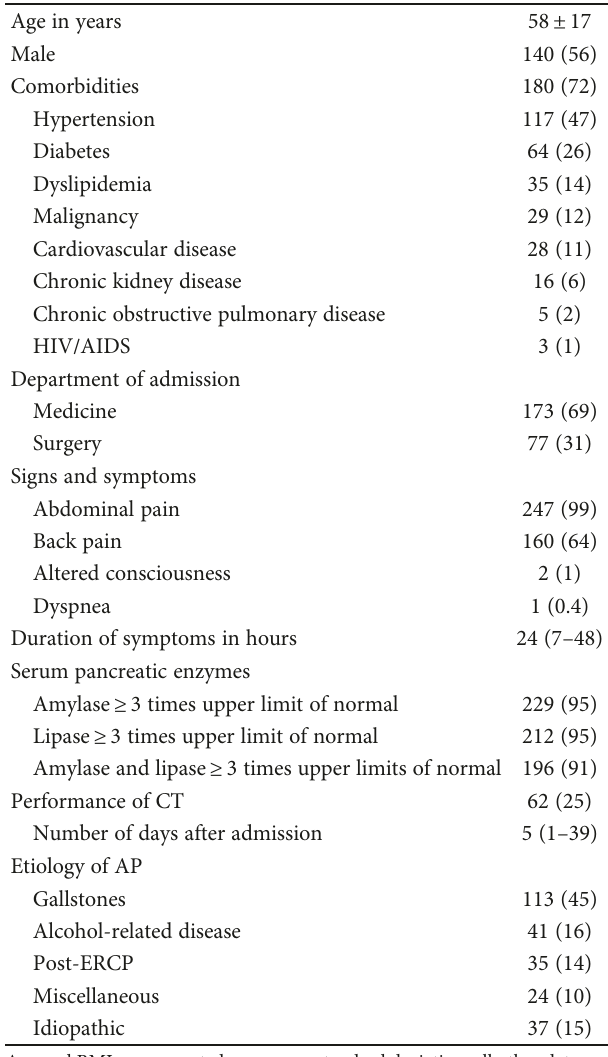
Table 1: Characteristics of the 250 patients with acute